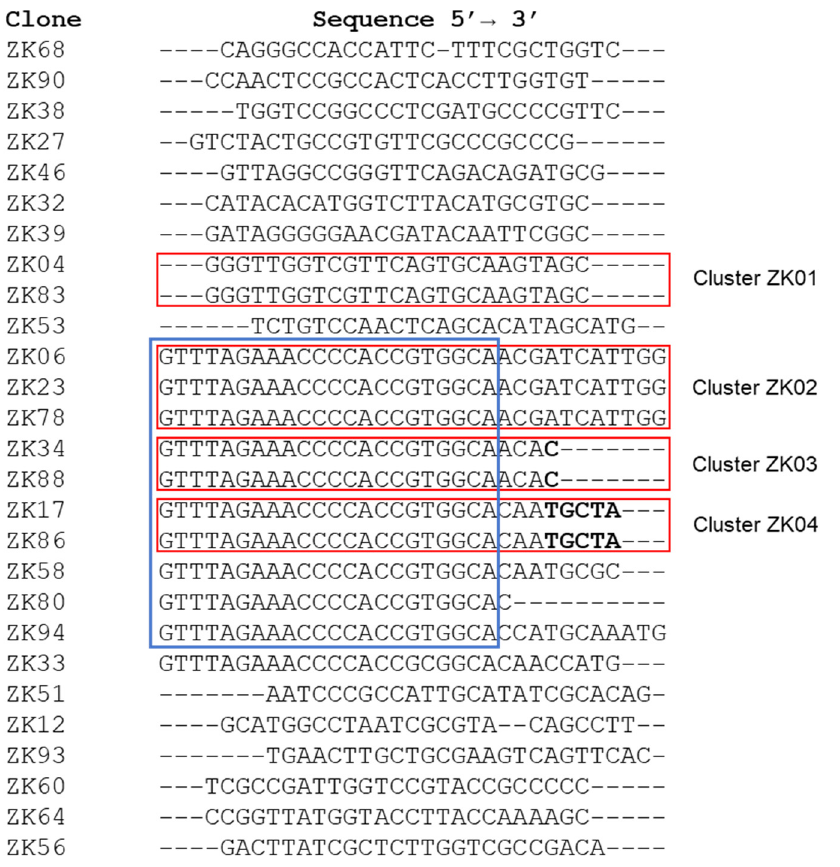
Figure 6. Alignment of the sequences obtained after selection against the whole Zika virus particle. Red rectangles indicate four clusters of aptamers. Blue square shows nucleotide homology between sequences. The nucleotides in bold were removed.